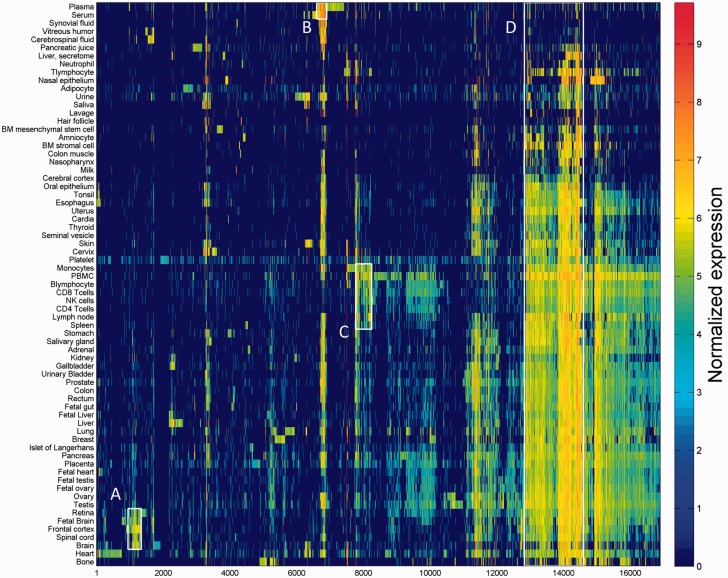
Double hierarchical clustering of the 16 900 genes in 69 normal anatomical entities. Examples of gene groups sharing functional annotations are highlighted. (A) CNS—397 genes enriched with diseases as schizophrenia, pathways as neuroscience and GO terms as transporter activity. (B) Blood—301 genes enriched with diseases such as obesity and C2 deficiency and GO terms as complement activation (C) Immune system—483 genes enriched with diseases such as rheumatoid arthritis and pathways as lymphocyte signaling. (D) Genes with housekeeping properties—1771 genes enriched with pathways and GO terms related to metabolism and gene expression. See Supplementary Tables S5–S8 for the full enrichment analysis data.